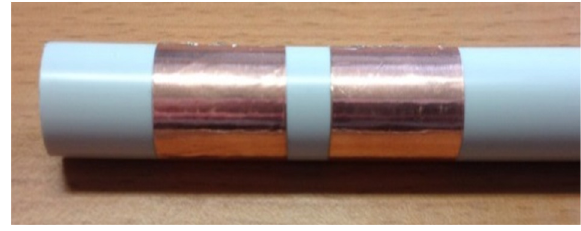
Figure 2. First design sensor.